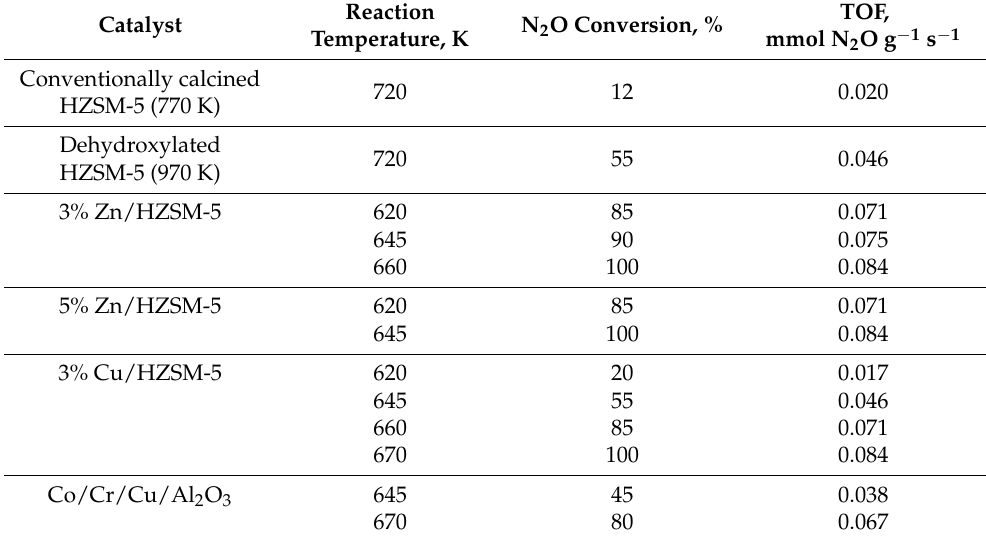
Table 1. N 2 O decomposition (45 cm 3 N 2